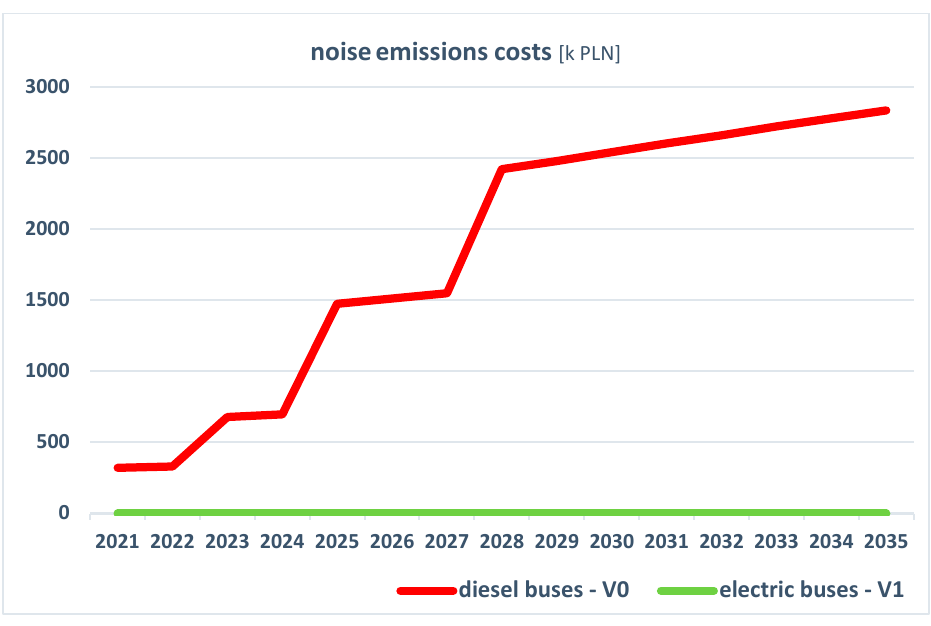
Figure 9. Projected amounts of noise emissions costs of the public bus fleet in Szczecin in the 2021–2035 period for variants V0 and V1. Table 6. Costs of NHMC/NMVOC, NOx, PM, SO 2 , CO 2 and noise emissions for: V0, V1 and V1 − V0.